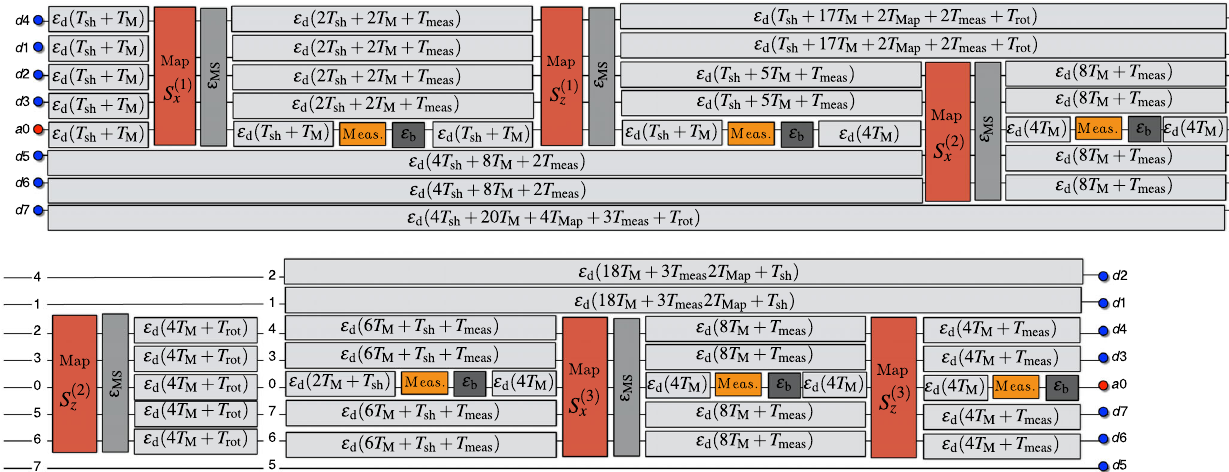
FIG. 17. Quantum-channel representation of shuttling-based one-species QEC cycle with multiqubit MS gates: The ion reconfiguration steps of Fig. 16 lead to an increase of the phonon populations and a dephasing of the idle qubits during the time required for these reconfigurations to take place. Additionally, idle ions also dephase during the time lapse of the stabilizer mapping. These time intervals are T for shuttling, T for merging or splitting, T for stabilizer mapping, T M sh Map channel applied during a certain period is depicted by light grey boxes, with the channel ε n T acting on a particular qubit, where n is the number of operations of the type o that occur within that period. The actual channel P o rot rot Þ n T = 2 T 2 , with T 2 being the coherence time of the qubits. The ancilla readout and corresponds to Eq. (13) with a probability p d ¼ o o o reset measure is modeled by a bit-flip channel (22) acting on the ancillary qubit ε ε ε measurement and reset errors p , as reported in Table II, and represented by dark grey boxes after each measurement. b ¼ meas þ res Finally, map is modeled by an ideal stabilizer mapping acting on the particular set of qubits, followed by a depolarizing channel ε grey box) given by one of the three channels of Eqs. (14) – (16) with an error probability p phonon number through Eq. (17), and the gate time via Eqs. (19) and